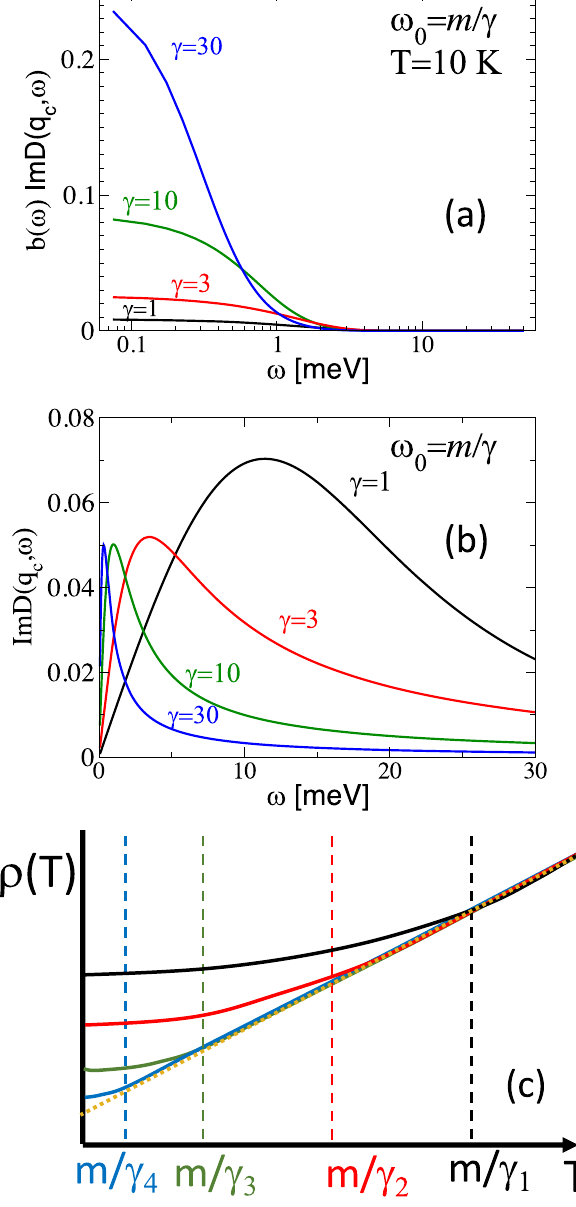
Fig. 1 Implications of the γ parameter. Sketch of the shift induced by an increasing damping parameter γ = 1 → 30 on the fl uctuation spectral function Im D in the presence ( a ) and in the absence ( b ) of a Bose thermal distribution; ( c ) sketch of the effect on the resistivity induced by the decrease of the characteristic energy ω 0 ≡ m / γ (with m = 10 meV) of the fl uctuations responsible for the quasiparticle scattering, with the scattering rate given by the imaginary part of the electron self-energy, computed at second order in the coupling g between electron quasiparticles and fl uctuations. The orange dotted line represents the Planckian limit (linearity down to T = 0), corresponding to a divergent γ